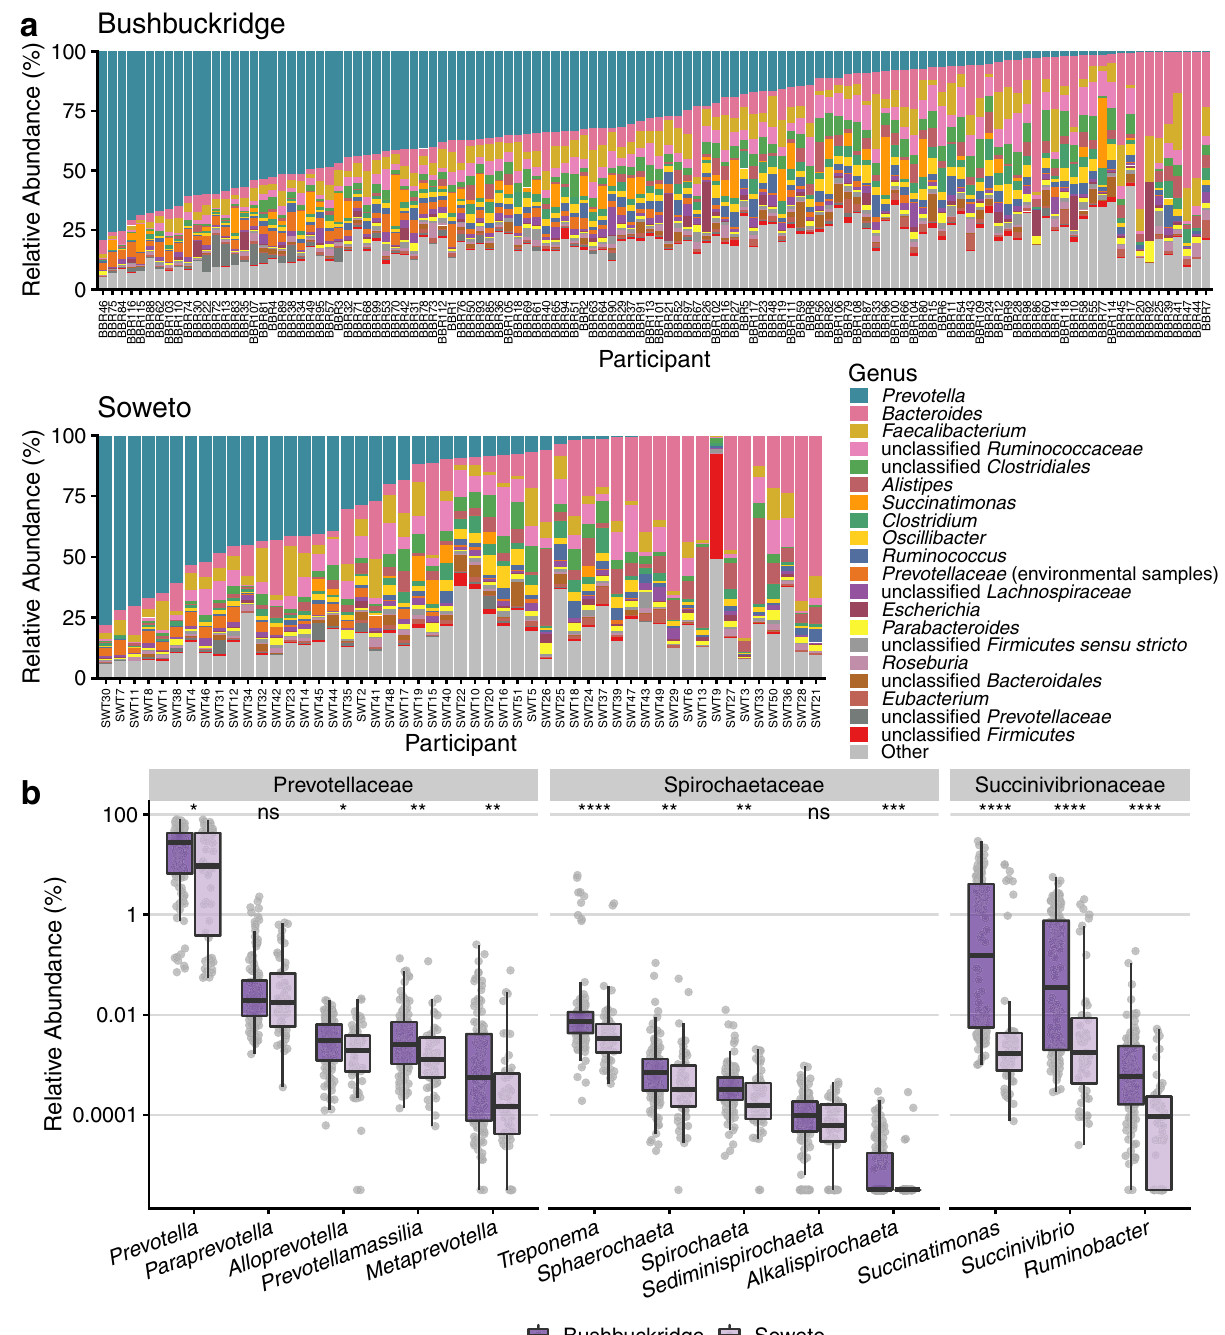
Fig. 1 Taxonomic composition of South African study participant microbiota. Sequence data were taxonomically classi fi ed using Kraken 2 with a database containing all genomes in RefSeq and GenBank of “ scaffold ” quality or better as of January 2020. a Top 20 genera by mean relative abundance for samples from participants in Bushbuckridge and Soweto, sorted by decreasing Prevotella abundance. Prevotella , Bacteroides , and Faecalibacterium are the most prevalent genera across both study sites. b Relative abundance of VANISH genera by study site, grouped by family ( n = 118 Bushbuckridge, n = 51 Soweto). A pseudocount of 1 read was added to each sample prior to relative abundance normalization in order to plot on a log scale, as the abundance of some genera in some samples is zero. Relative abundance values of most VANISH genera are higher on average in participants from Bushbuckridge than Soweto (two-sided Wilcoxon rank-sum test, signi fi cance values denoted as follows: * p < 0.05, ** p < 0.01, *** p < 0.001, **** p < 0.0001, (ns) not signi fi cant). Exact p values from left to right: 3.91e − 2, 3.28e − 1, 1.60e − 2, 4.55e − 3, 6.64e − 3, 1.93e − 5, 9.20e − 3, 7.29e − 3, 6.93e − 2, 6.87e − 4, 1.64e − 11, 7.66e − 6, 1.02e − 7. Box plot lower and upper hinges correspond to the fi rst and third quartiles, upper and lower whiskers represent the highest and lowest values within 1.5 times the interquartile range, and the horizontal line represents the